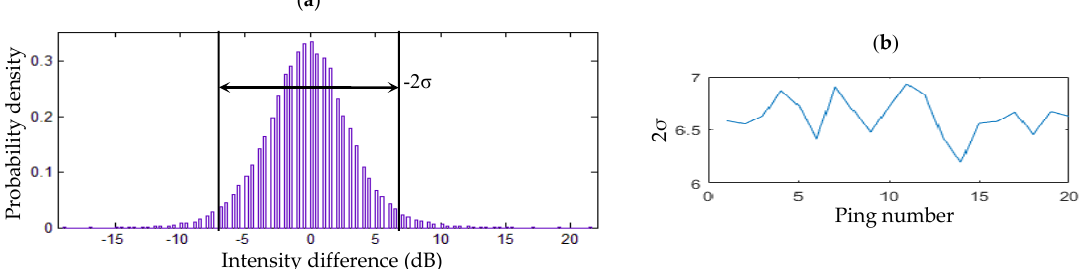
Figure 15. Determination of T dB in odd-ping middle sectors. ( a ) Probability density distribution of middle-sector backscatter intensity differences in the chosen 20 odd pings. ( b ) Curve of the standard deviations; the σ s of the middle-sector backscatter intensity differences in the 20 odd pings.